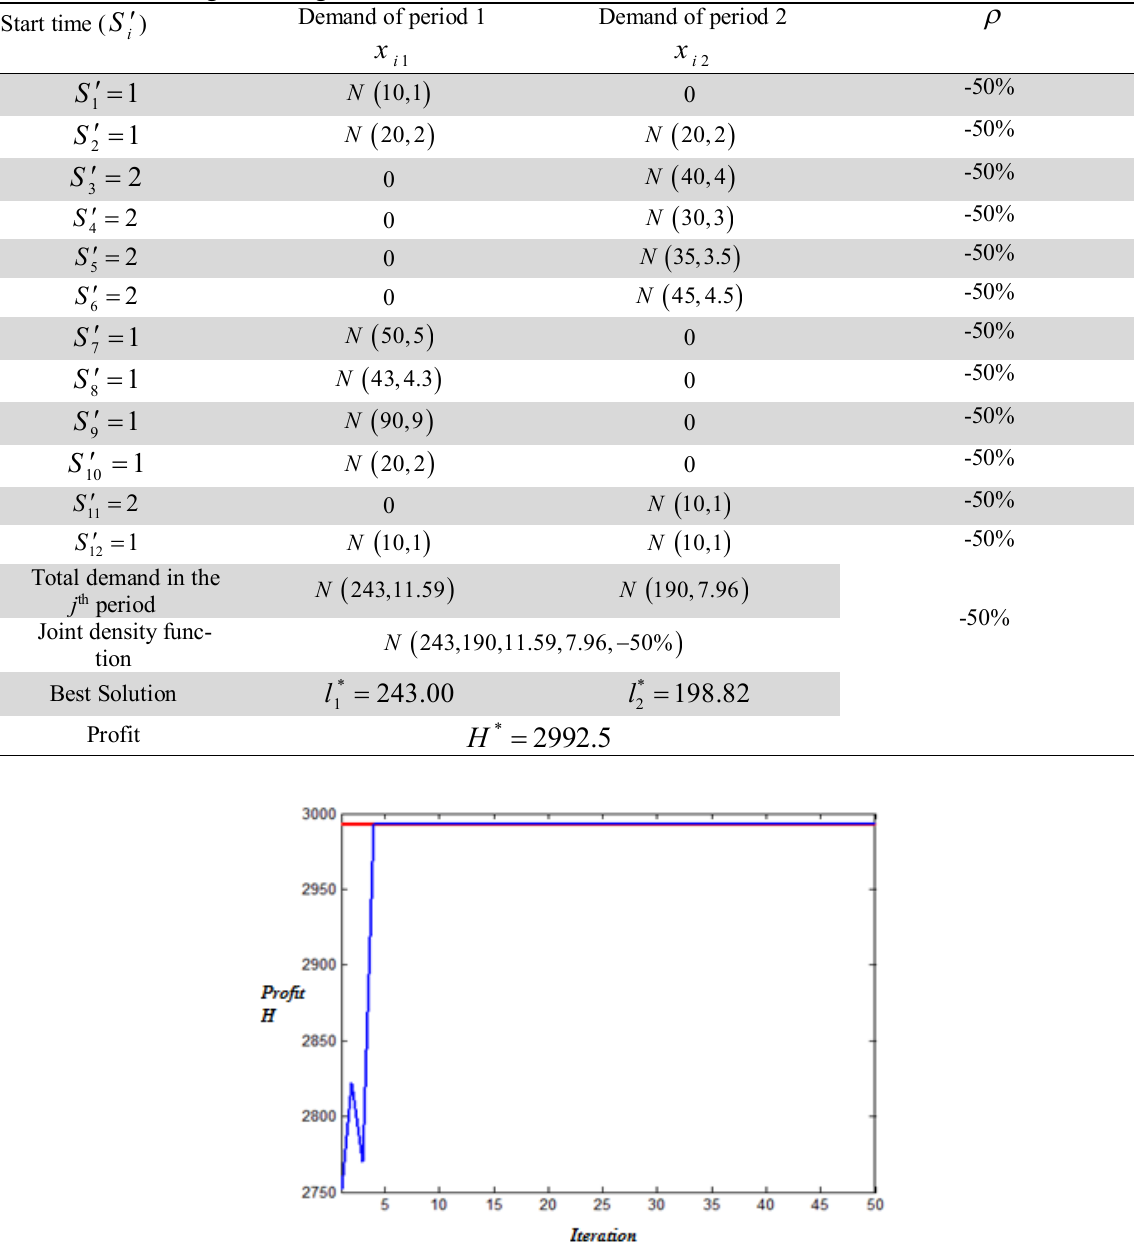
Final results of the genetic algorithm